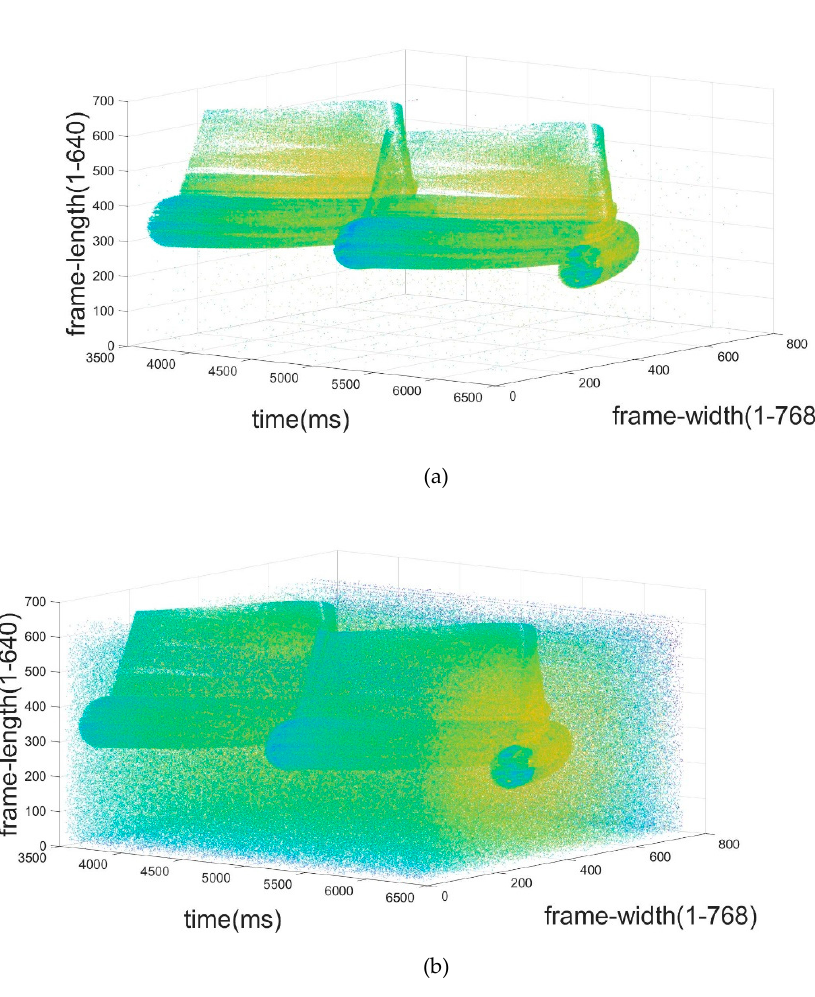
Figure 7. Filtering result of Liu ‘s filter with subsample factor of 2: ( a ) is the result of denoising and ( b ) is the filtered noise.